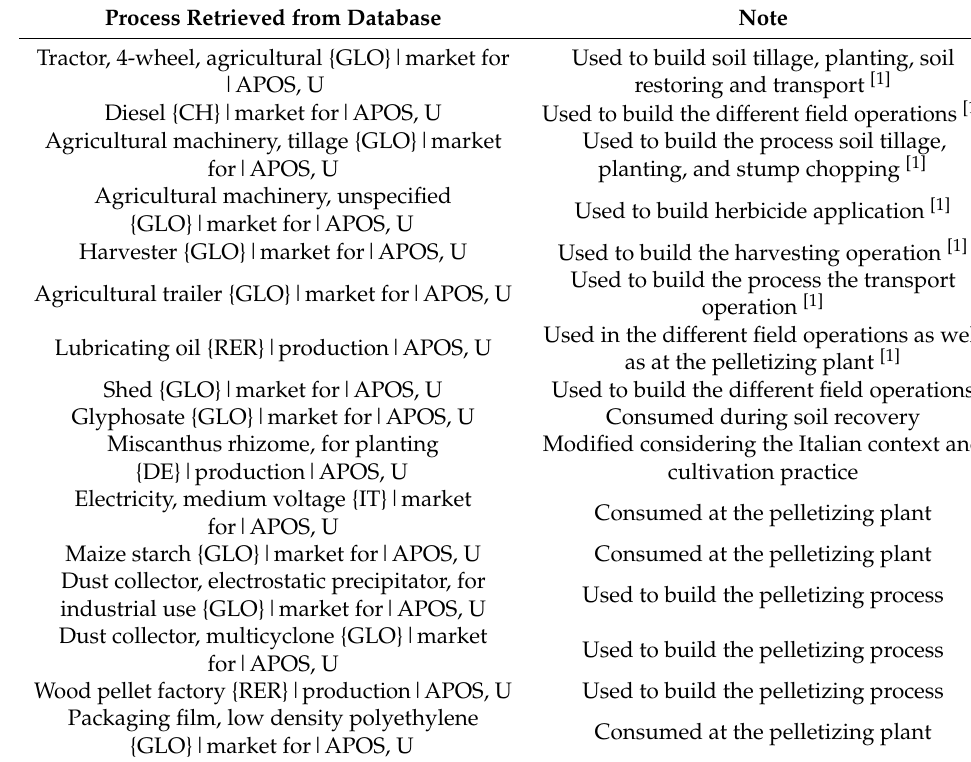
Table 4. List of processes retrieved by the